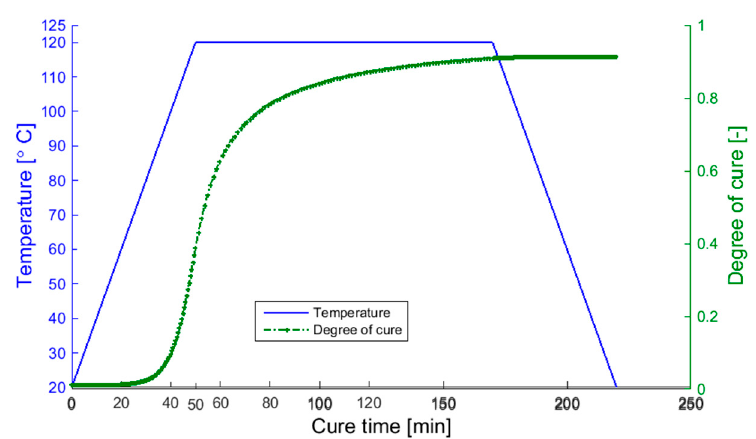
Figure 2. Cure cycle of CYTEC FM-64 epoxy [62].